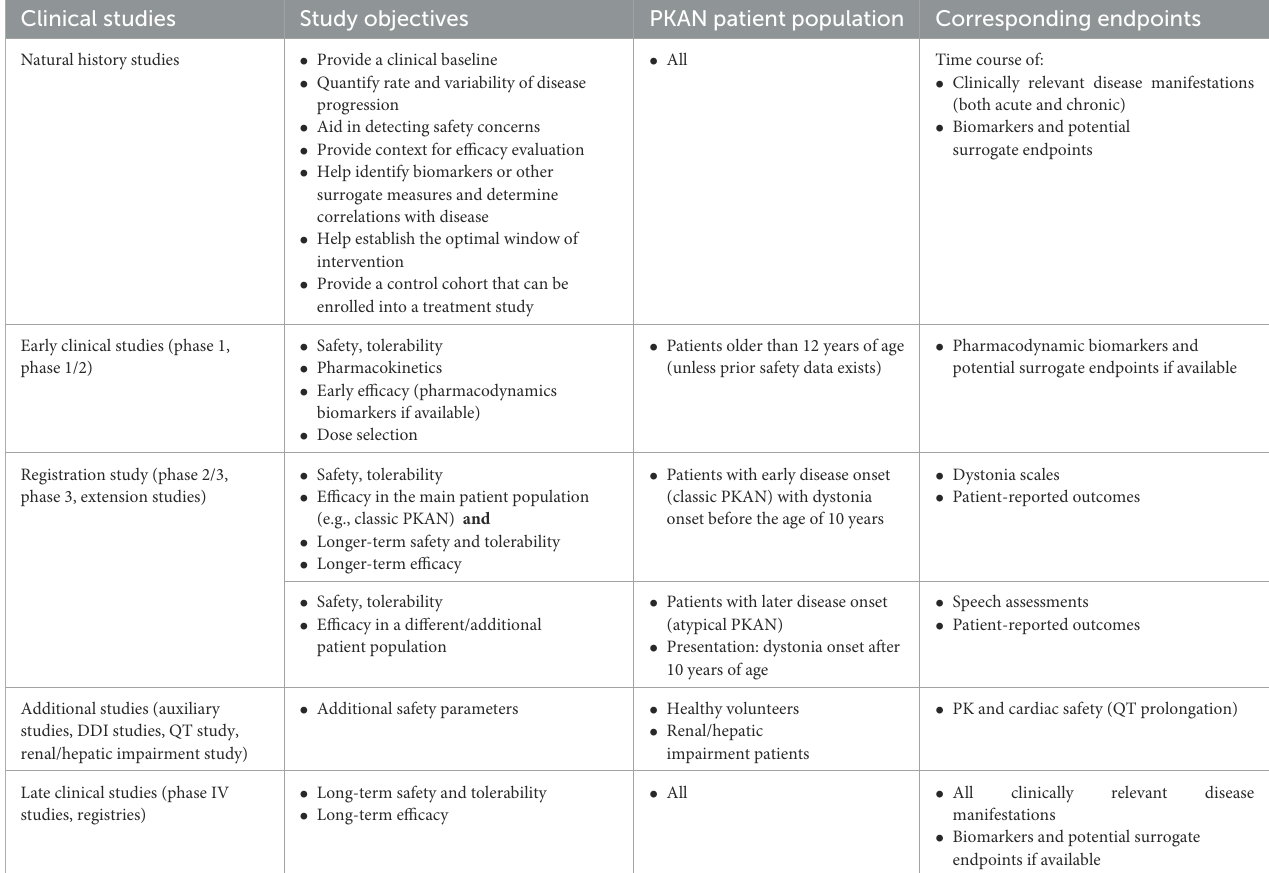
TABLE 1 Clinical development program potential clinical studies: an example using